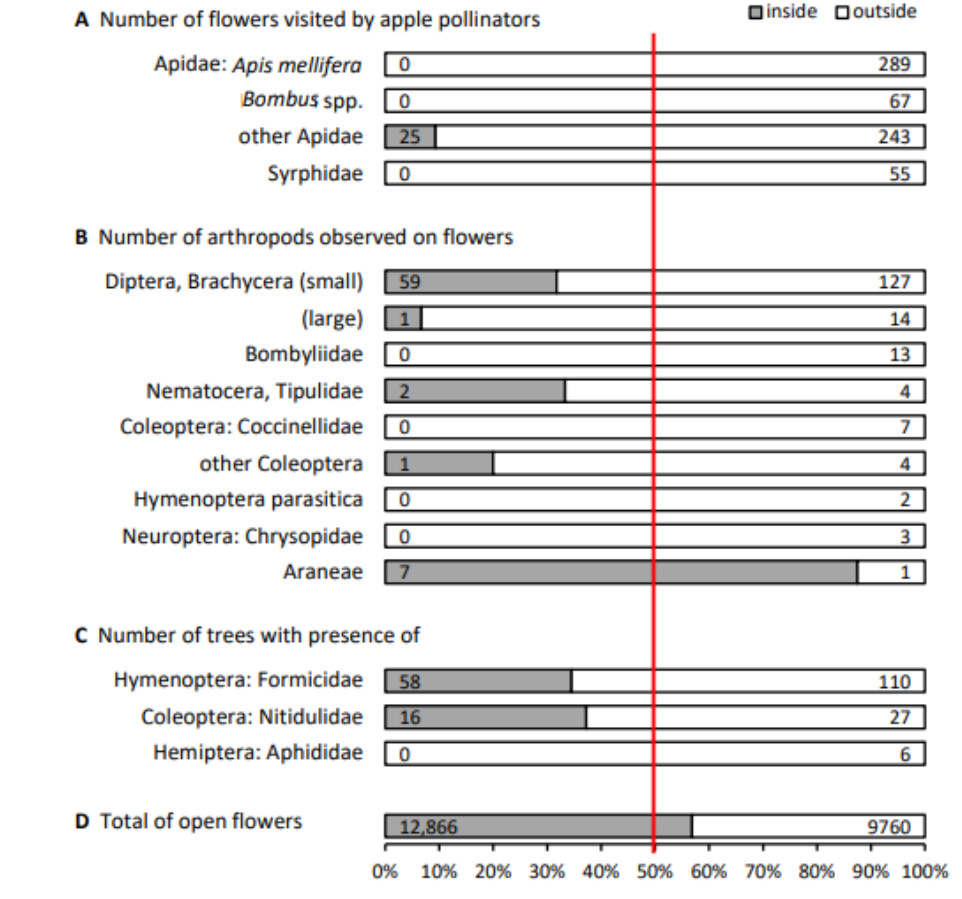
Figure 6. Flower visitation observations inside and outside the netted plot of apple trees during the flowering period in the years 2016–2019. ( A ) relative numbers of observed apple flowers visited by apple pollinators, ( B ) numbers of other arthropods observed in or on flowers, ( C ) numbers of trees infested with ants (Formicidae), pollen beetles (Nitidulidae), or aphids (Aphididae), and ( D ) estimated total numbers of open flowers on the observed trees. The red line indicates equal numbers inside and outside. Absolute numbers are displayed in the bars.